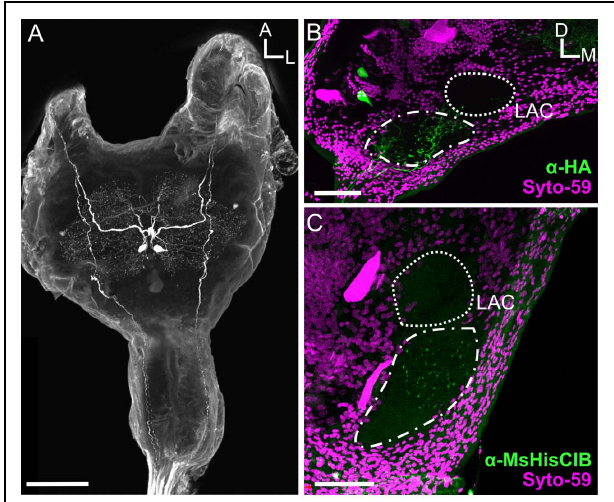
FIGURE 6 | The MDHns survive metamorphosis, but the MsHisClB receptor is not expressed in the LAC. (A) Horizontal view of HA-ir in the fifth instar larval MsG shows highly similar cell morphology and radiation patterns of fine processes as in the adult MsG. (B) HA-ir in the larval brain (green) shows extensive branching in the tritocerebrum (dash-dot line), but very little innervation in the LAC (dashed line). Syto-59 (magenta) highlights the boundary of the tritocerebrum and LAC. (C) MsHisClB-ir (green) is present in the tritocerebrum, but not in the LAC. LAC and tritocerebrum highlighted with Syto-59 (magenta) as in (B) . All scale bars = 100 μ